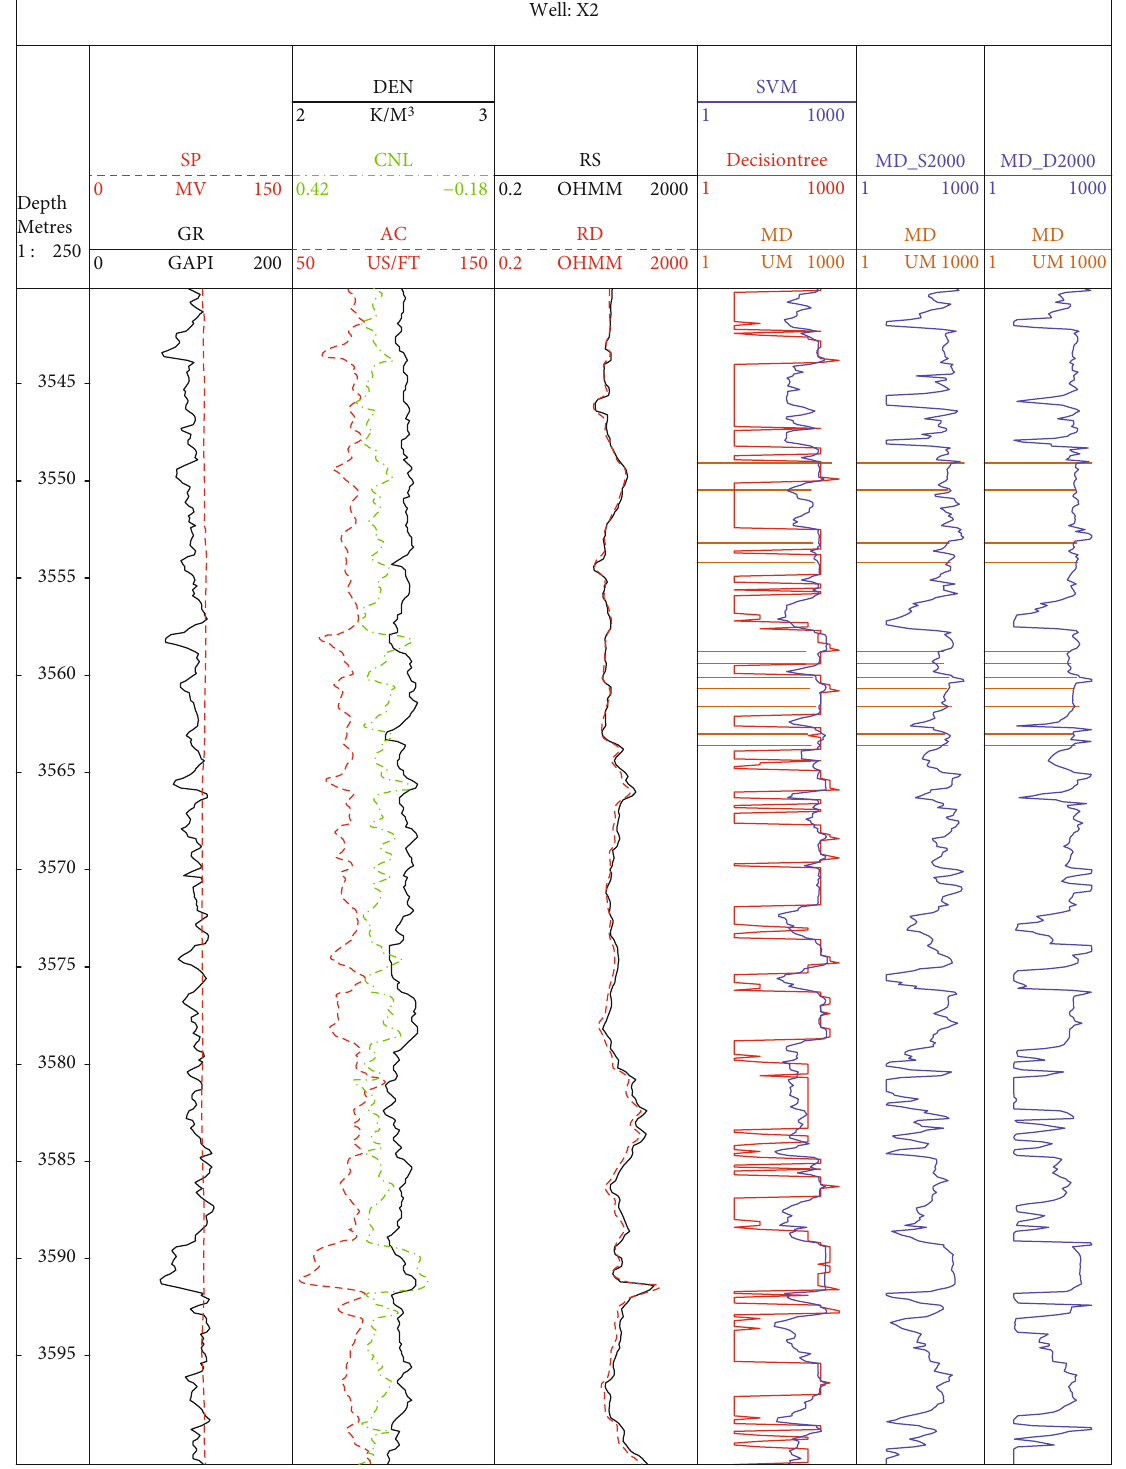
section of well 3